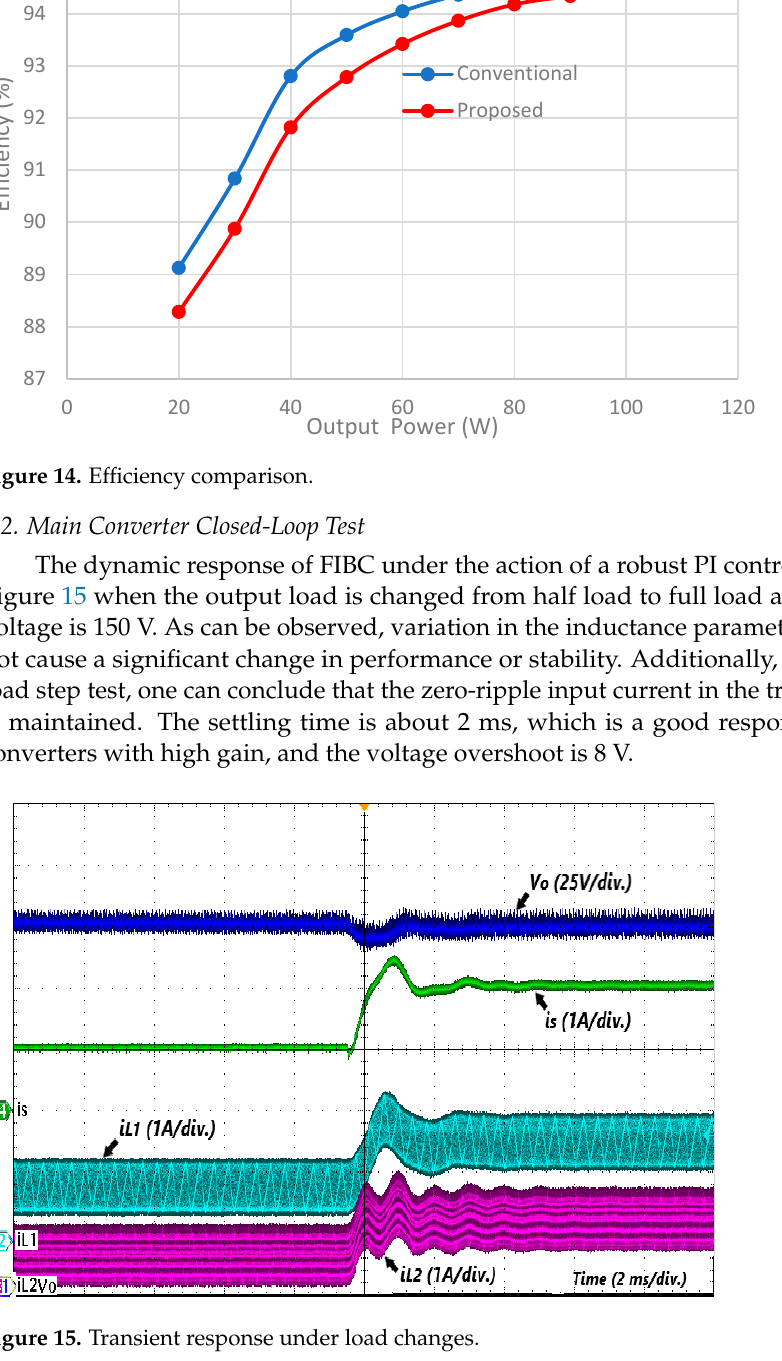
Figure 16. Transient response under input voltage change.